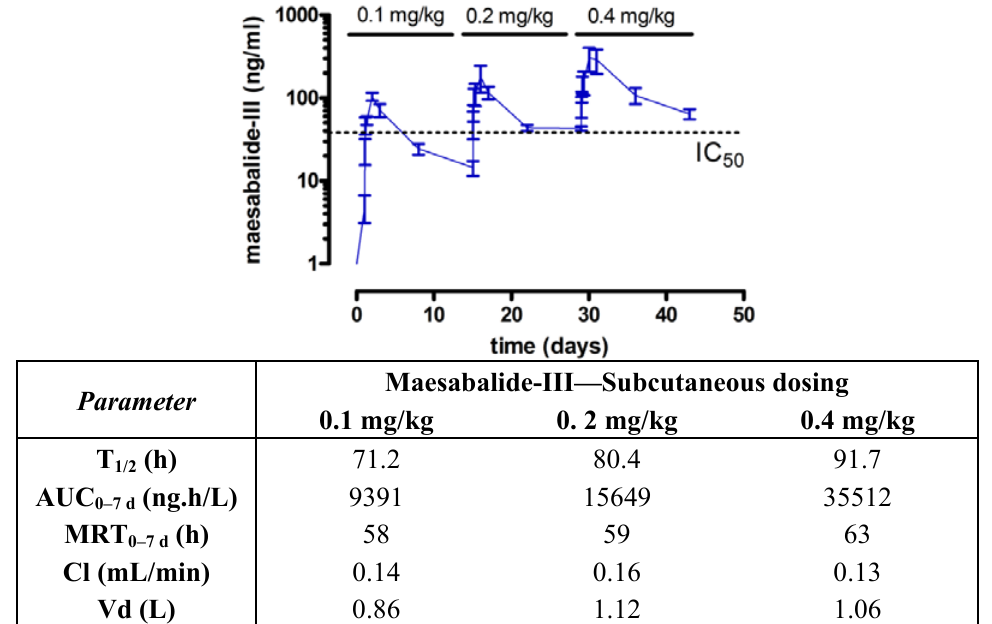
Figure 5. Plasma kinetics of maesabalide-III (n = 4) after subcutaneous dose-escalation (0.1, 0.2 and 0.4 mg/kg at weekly intervals) in dogs. The dashed line represents the in vitro IC value of PX-6518 against intracellular amastigotes Leishmania infantum (taken from 50 ref [20]). Pharmacokinetic parameters are listed in the